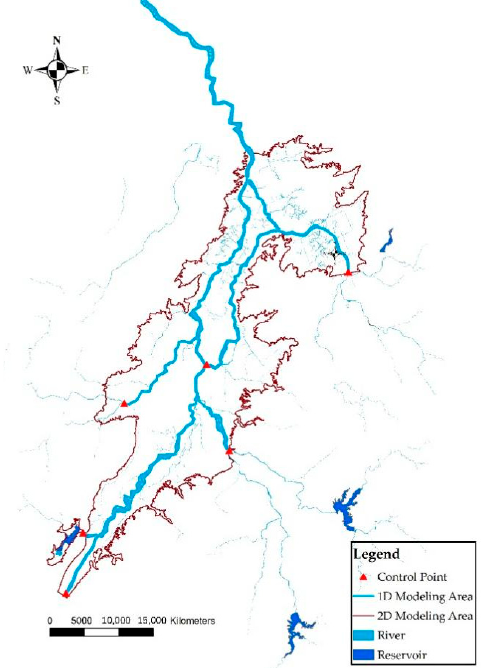
Figure 4. 1D and 2D hydrodynamic modeling area.